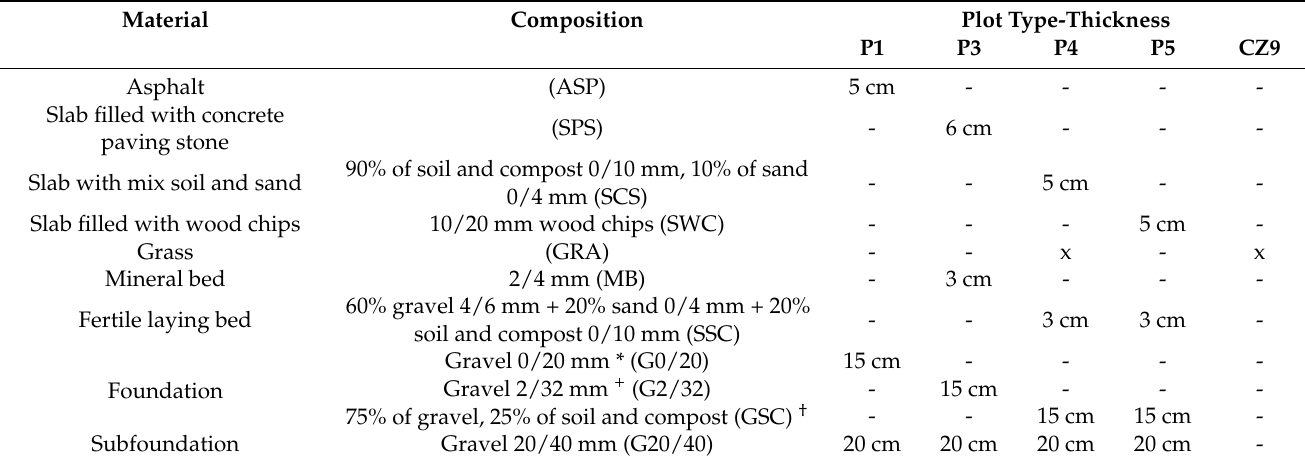
Table 1. Description of the four parking lots (P) and the control zone